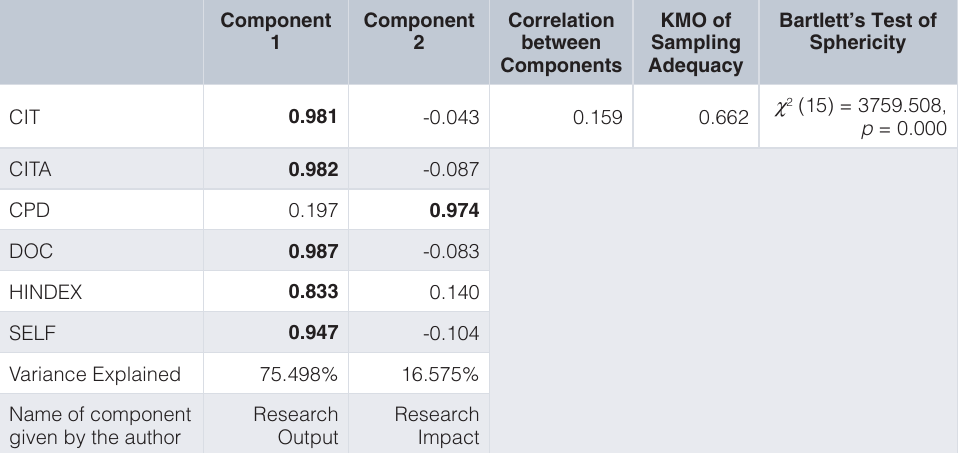
Table 2. Component loadings of principal component analysis.